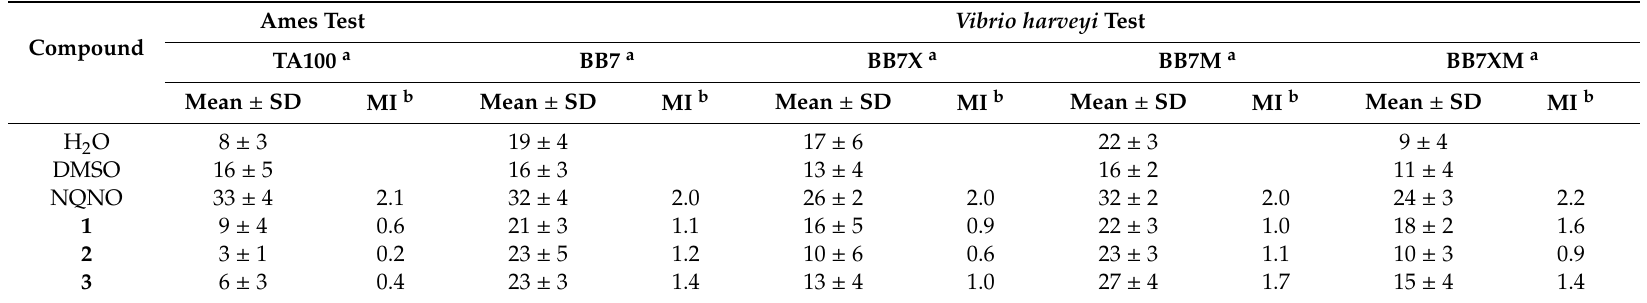
Table 2. Mutagenic activity of tested compounds in the Ames and the Vibrio harveyi tests.